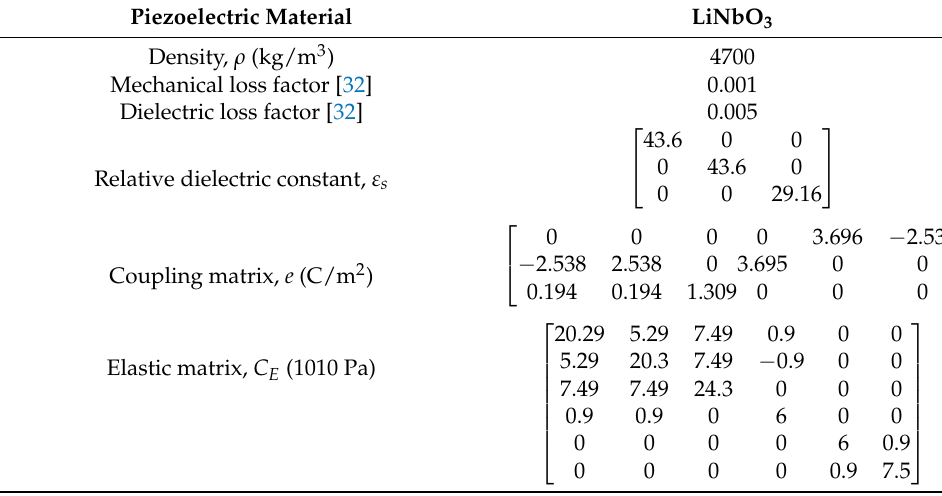
Table 2. Parameters of piezoelectric material used in the simulation.